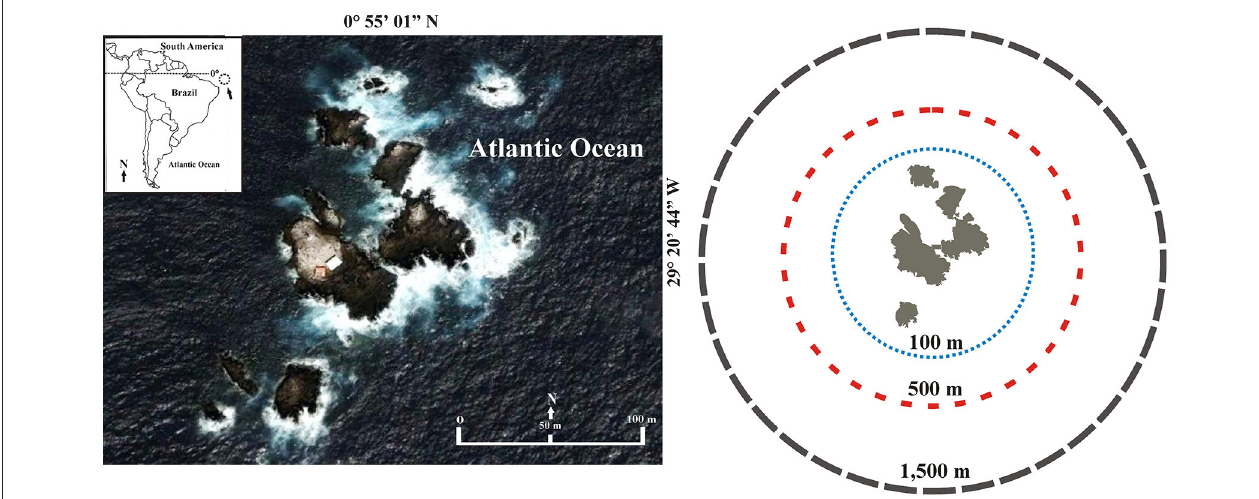
FIGURE 1 | Saint Peter and Saint Paul Archipelago. Distances from the Archipelago: D1, < 100m; D2, > 100–500m; and D3, > 500–1500m. Source: Google Earth (2016) 1